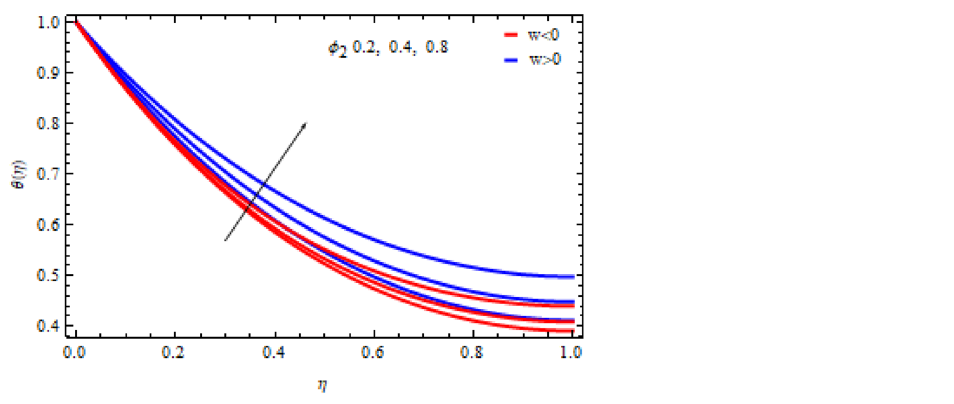
Figure 7. Temperature field by φ 2